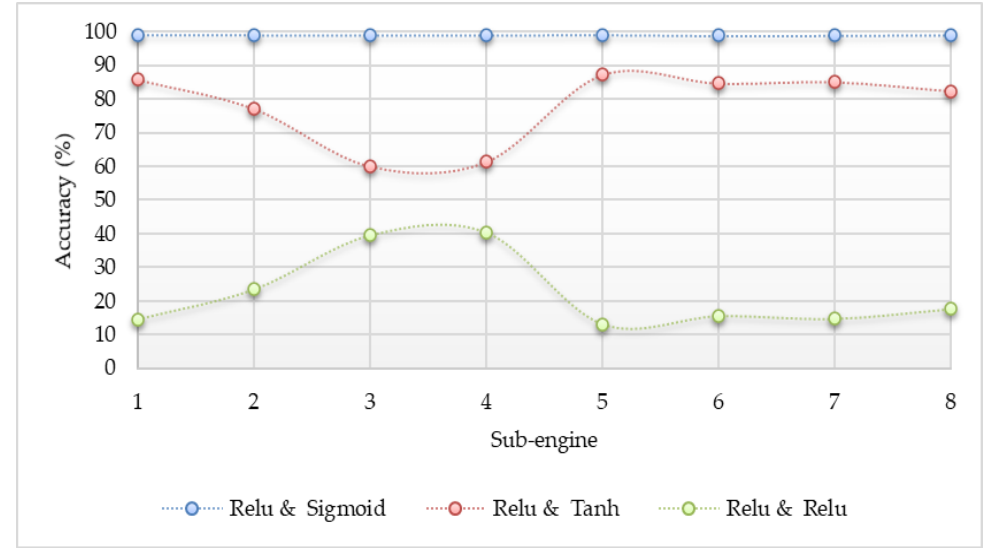
Figure 5. Accuracy comparison for detecting IoT botnets attacks by a simple neural network (ReLU in the hidden layer and different functions in the output layer).